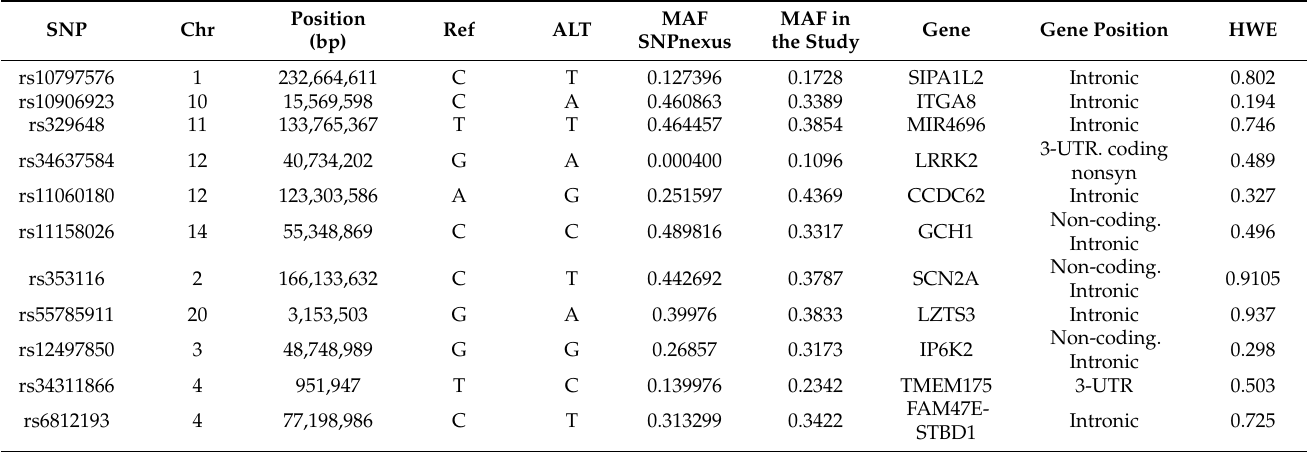
Table 3. Annotation of SNPs associated with